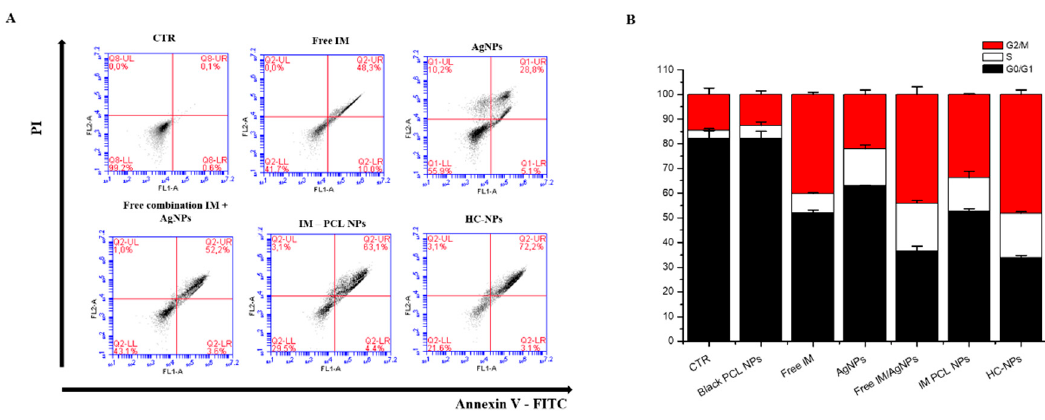
Figure 5. Analysis of cell apoptosis ( A ) and cell cycle ( B ) of KU812 leukaemia cells after 24 h of treatments with different formulations, compared with untreated control cells (CTR). Representative measurements of three independent experiments have been reported ( P < 0.05).